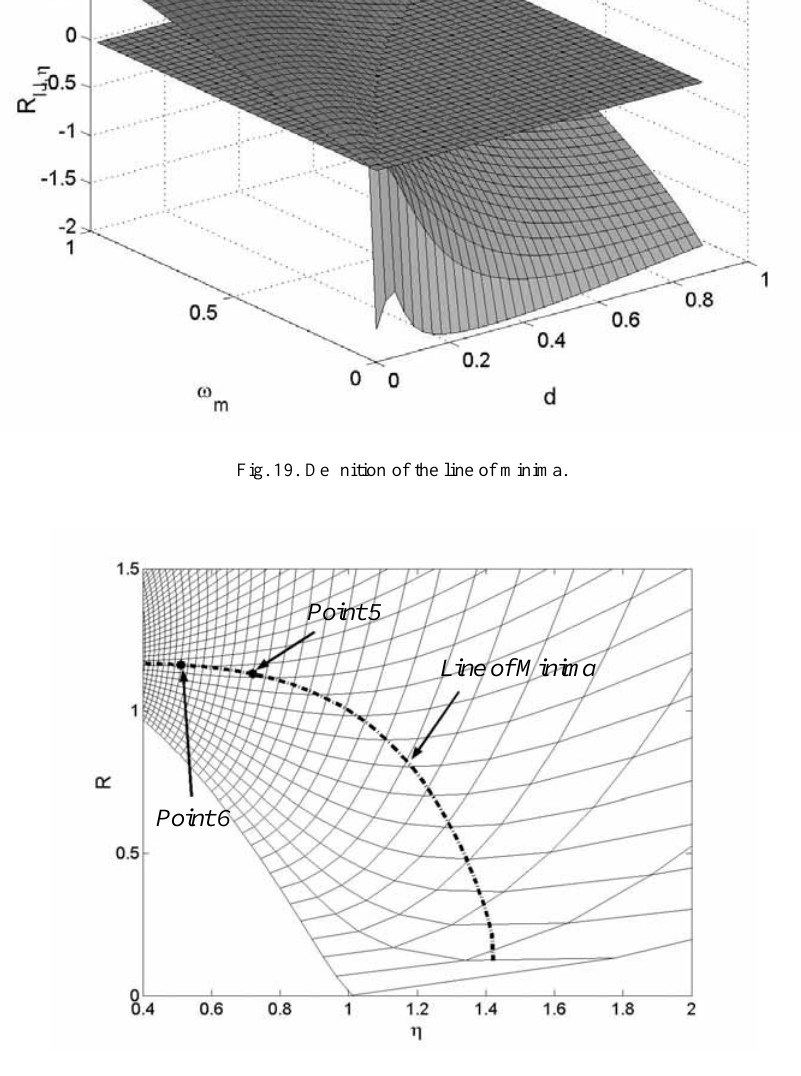
Fig. 20. R - η plane illustrating the line of